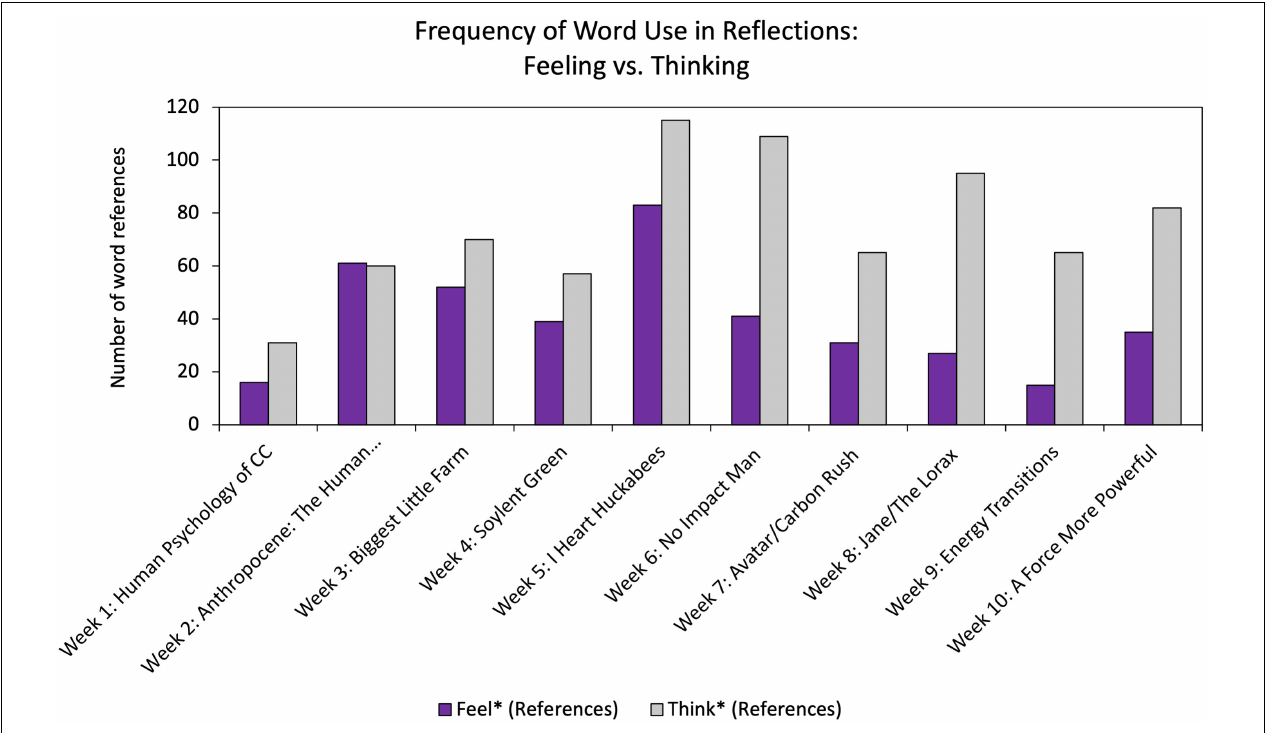
FIGURE 1 | Frequency of “feel” versus “think” words in reflection assignment over 10 weeks, using stemmed text query (which includes words with the same root, e.g., feeling and thinking).